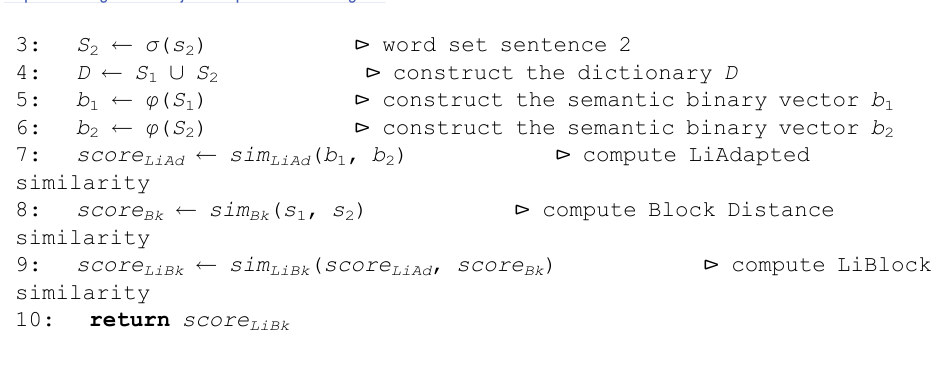
Fig 1. This figure details the workflow for computing the new LiBlock measure and an example illustrating a use case of the workflow following the steps defined in algorithm 1.